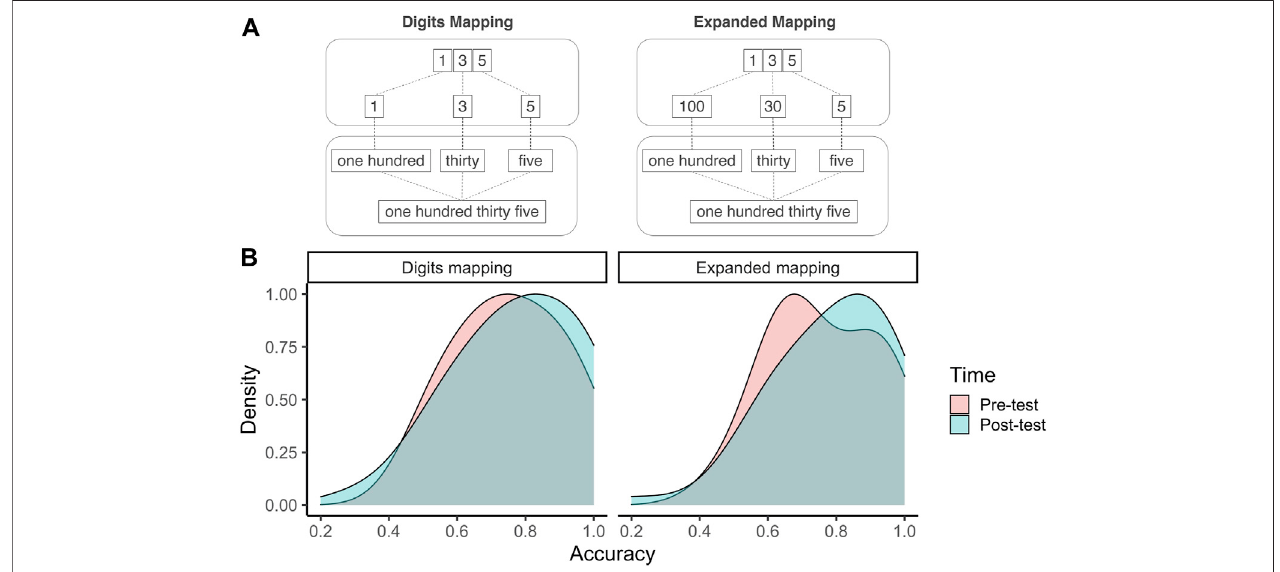
FIGURE 4 | (A) : Illustrations for the two mapping conditions in Experiment 2. (B) : Density graphs of participants ’ accuracy in Experiment 2 by condition and test time (Pre- and Post-test). Pink indicates pre-test performance and turquoise indicates post-test